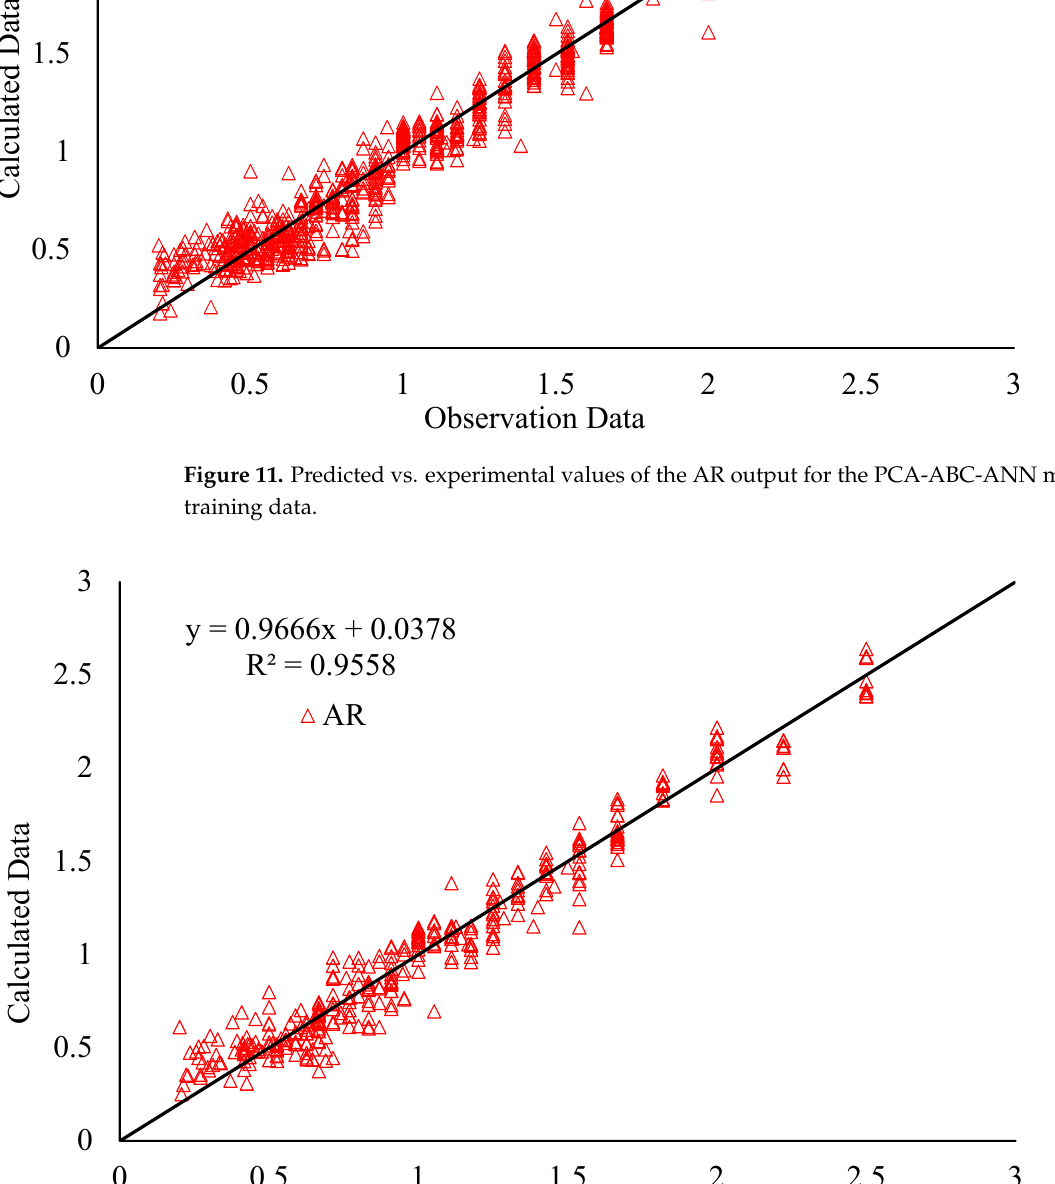
Figure 12. Predicted vs. experimental values of the AR output for the PCA-ABC-ANN model using testing data.